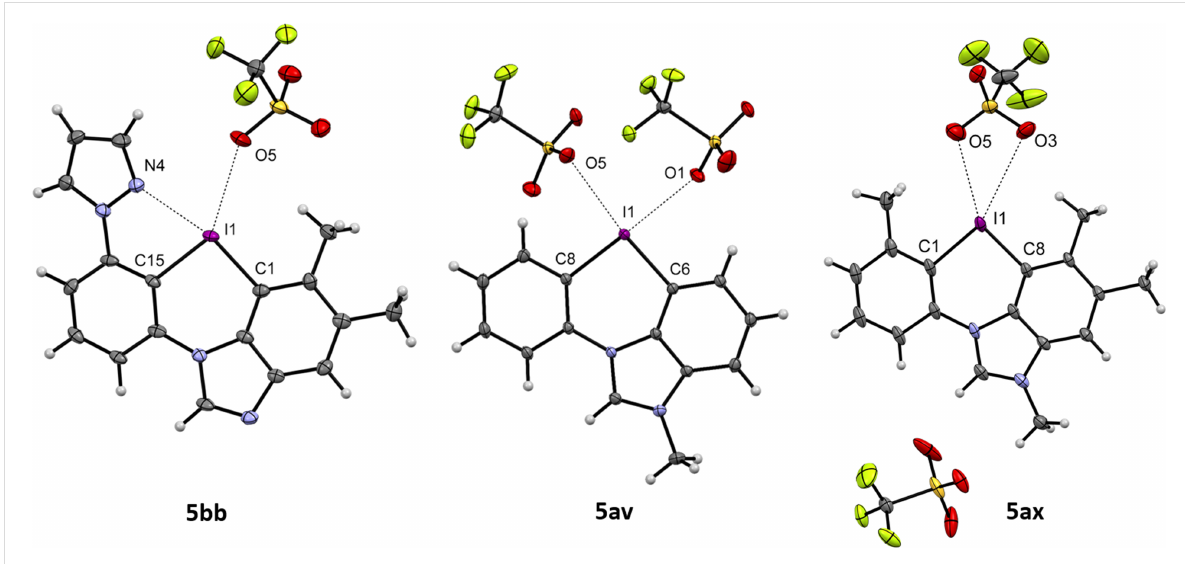
Figure 3: Single crystal structures (ORTEP drawing with 50% probability) of the pyrazole-coordinated salt 5bb (dimer, a second structure was omitted for clarity. For full structure, see Supporting Information File 1; CCDC 2216124) and the two N -methylated, dicationic salts 5av (CCDC 2216134) and 5ax (CCDC 2216127). Selected bond lengths and angles: For 5bb : N4–I1: 2.540 Å, I1–O5: 2.905 Å, N4–I1–C1: 185.74°, C15–I1–O5: 145.50°; for 5av : I1–O1: 2.705 Å, I1–O5: 2.898 Å, C8–I1–O1: 173.80°, C6–I1–O5: 167.75°, C6–I1–C8: 94.05°; for 5ax : I1–O3: 3.354 Å, I1–O5, 3.078